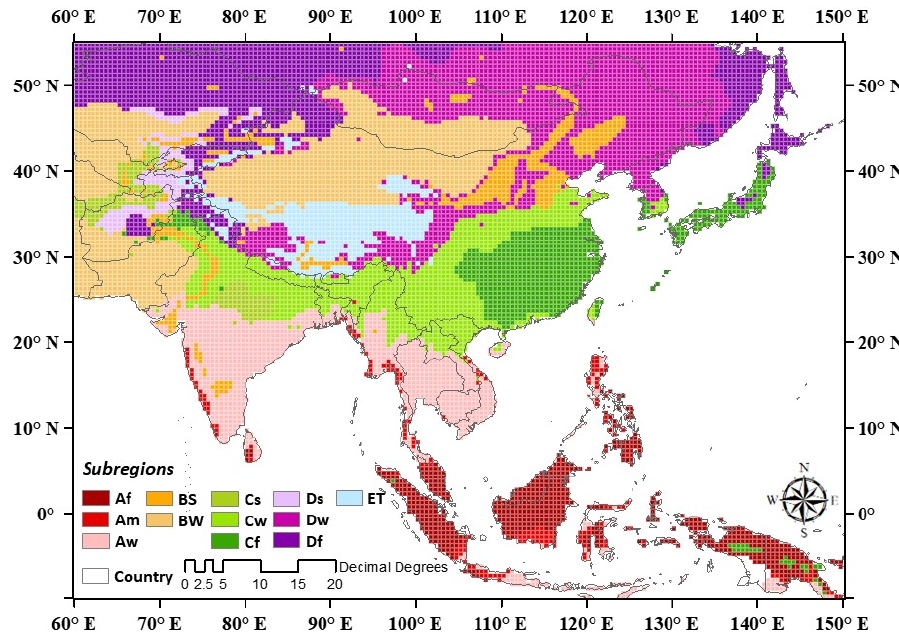
Figure 2. The spatial extent of study region with classified subregions for the regional analysis. The black lines indicate the boundary of each country in the Asia monsoon region. The individual grids with 12 different colors indicate the classified climate zones based on the Köppen climate zone method [35].